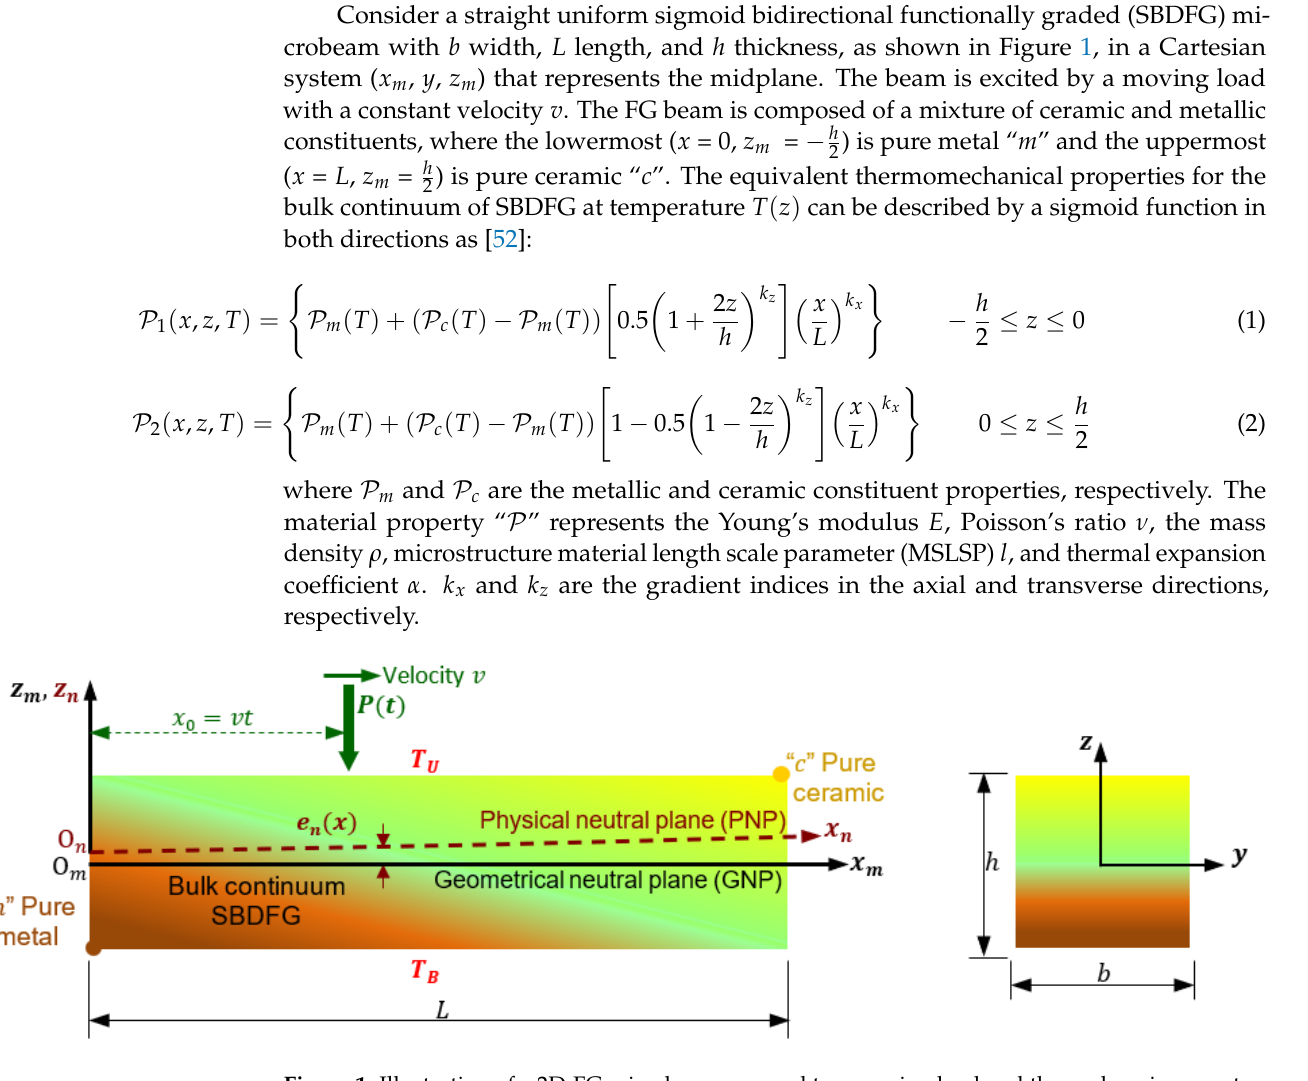
Figure 1. Illustration of a 2D ‐ FG microbeam exposed to a moving load and thermal environment.